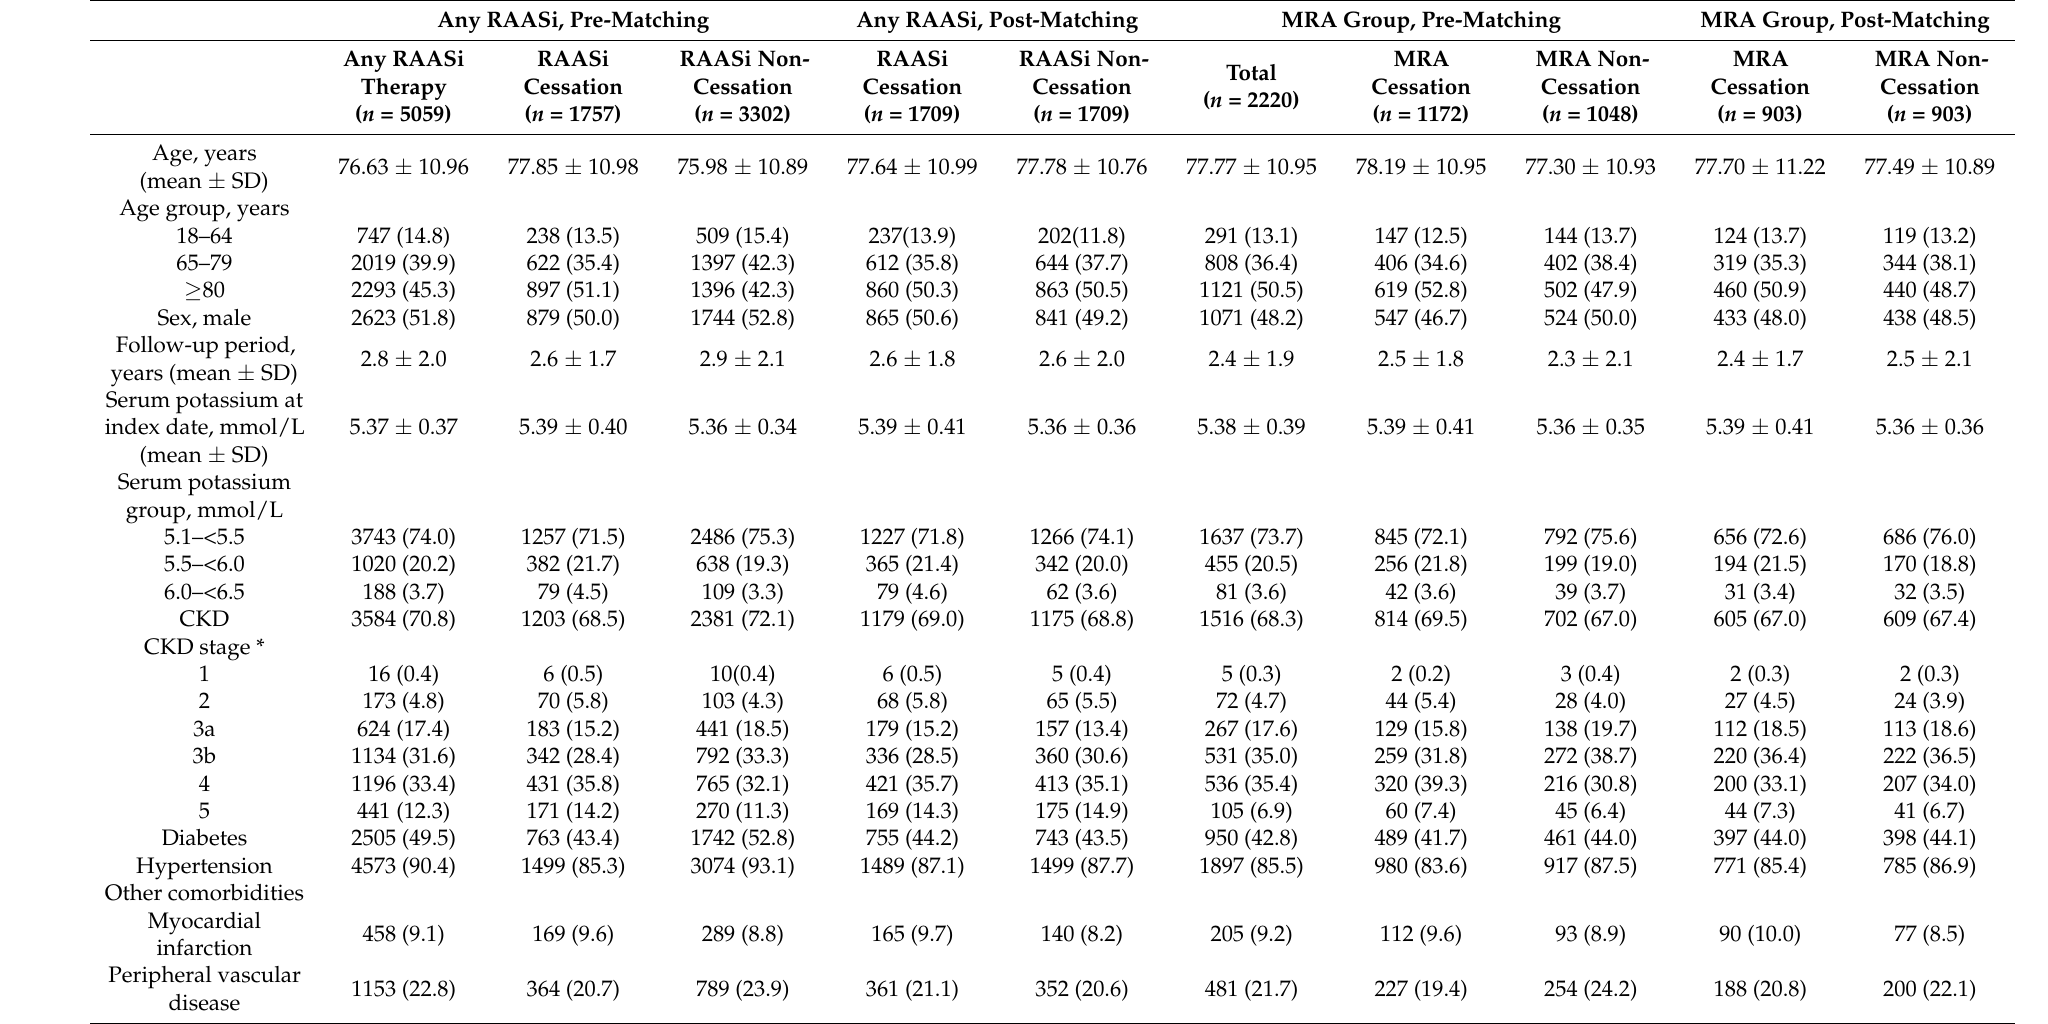
Table 1. Baseline patient